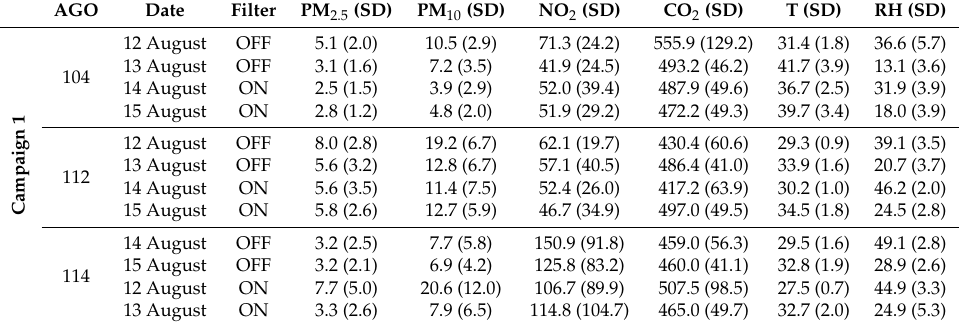
Table A1. Daily average in-cabin concentrations of PM 2.5 , PM 10 , NO 2 and CO 2 and temperature and relative humidity for the three different campaigns with standard deviations (SD), when the Air Filtration System (AFS) was switched on and off. All parameters are based on 1 min time averages. PM values are in µ g m − 3 , whereas NO 2 values are in ppb, CO 2 is in ppm, T in ◦ C and RH